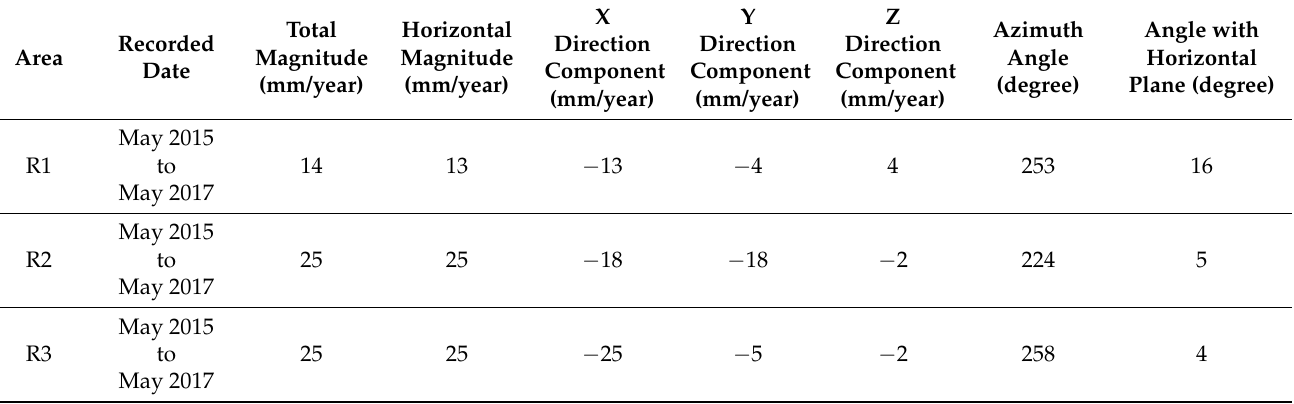
Table 6. Summary of calculated R magnitude and geometry for the South Extension landslide.